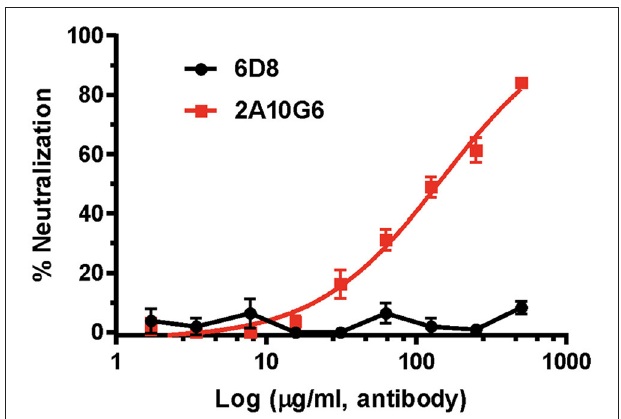
FIGURE 9 | The neutralizing activity of c2A10G6 against ZIKV. Dilutions of c2A10G6 or 6D8 (negative control) were co-incubated with 100 PFU of ZIKV and Vero cells for 3 days. Plaques were counted and percent neutralization and EC 50 were calculated. Experiments were performed twice with technical triplicates for each sample. Bars represent the standard deviation (SD) of the